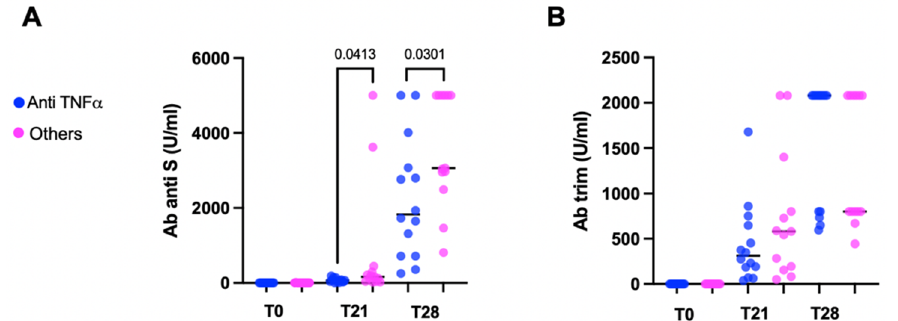
Figure 2. Difference between pIBD patients on anti-TNFα drugs and pIBD patients receiving other treatment regimens in terms of anti-S ab ( A ) and trim ab ( B ). Unpaired non-parametric test (Mann– Whitney test) was used for comparison.